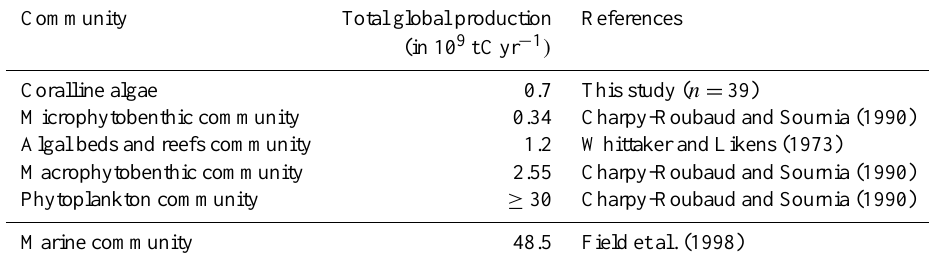
Table 3. The total global production of different coastal communities compared to the total marine oceanic production. The macrophytoben- thic community in Charpy-Roubaud and Sournia (1990) included brown algae, seagrasses, mangroves and salt